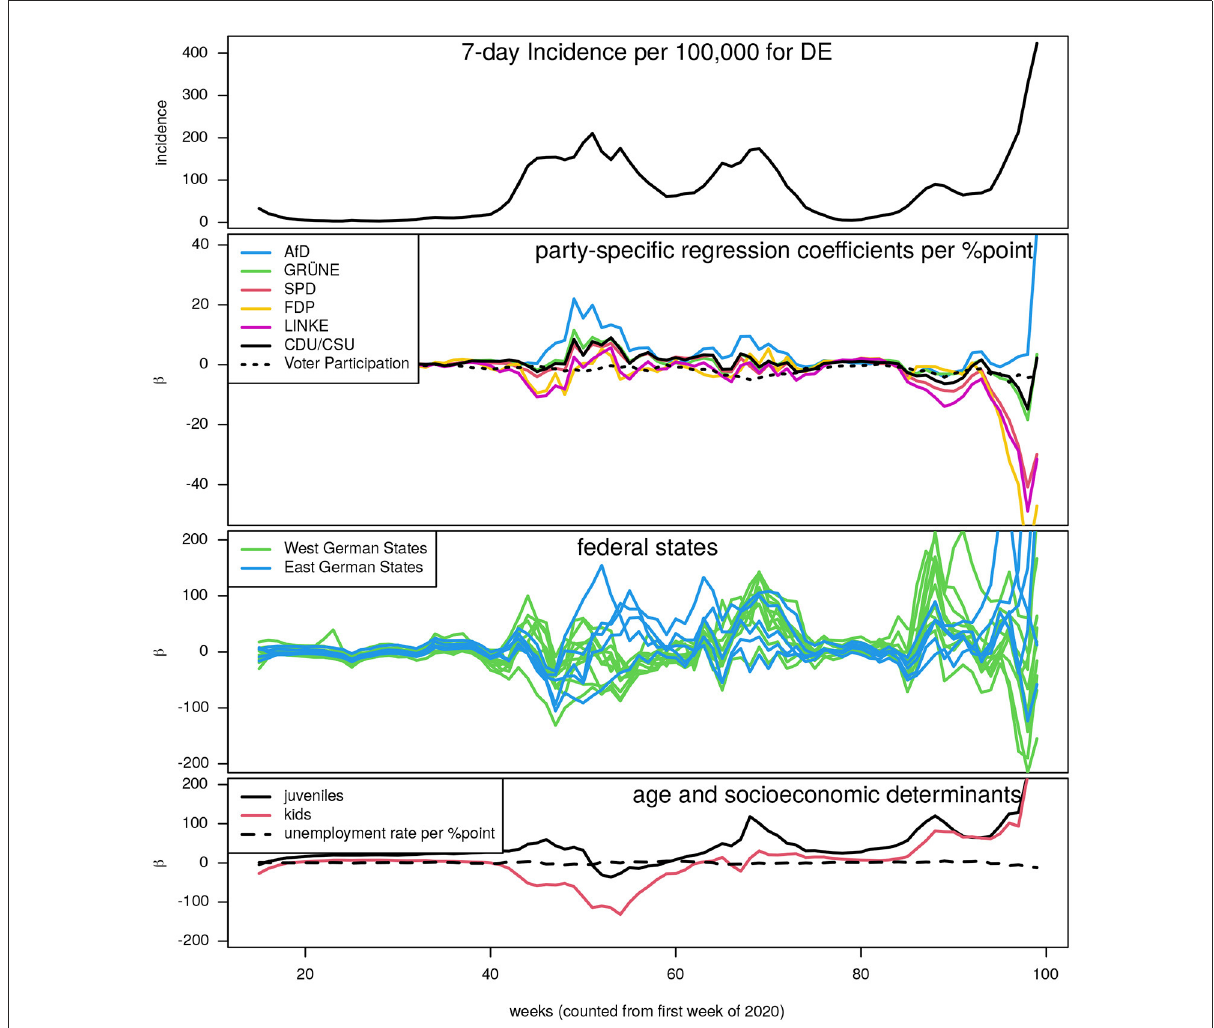
FIGURE2 Time courses of regression parameters obtained from random effect linear regression modeling sequentially applied at all available time points during the observation time. Panel on top: the German COVID-19 7-day-incidence per 100,000 curve (to allow for a mapping of the results to the epidemic history). Other panels from top to bottom: regression parameters in units “per percentage point” corresponding to (i) the share of votes (including voter participation), (ii) the federal states (for a better visibility all West German states depicted in green, East German states in blue), (iii) age classes (adults are reference) and percentage of